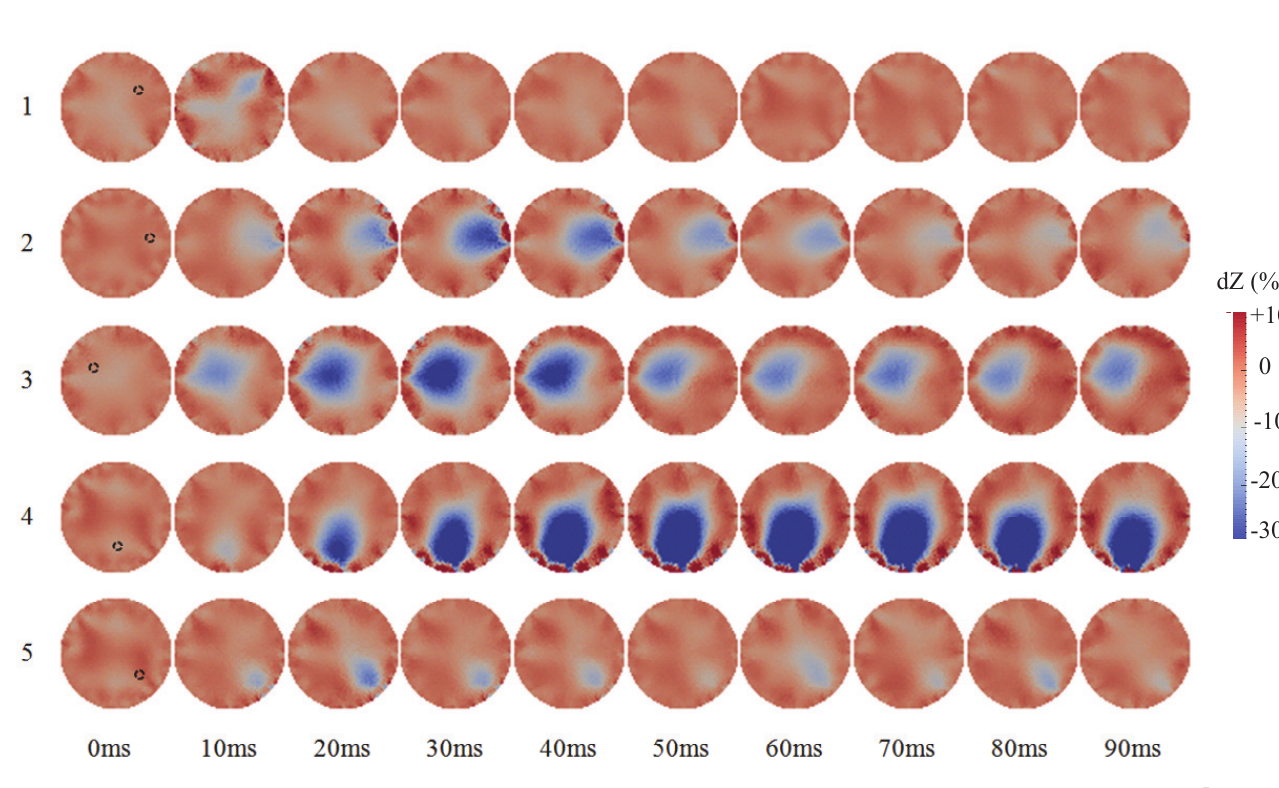
Fig 5: Results of coin drop experiment. 10 frames are shown, taken 10 ms apart, for each coin dropped. Each frame uses 1 ms of recorded data. The black circle at 0 ms indicates the position at which the coin was